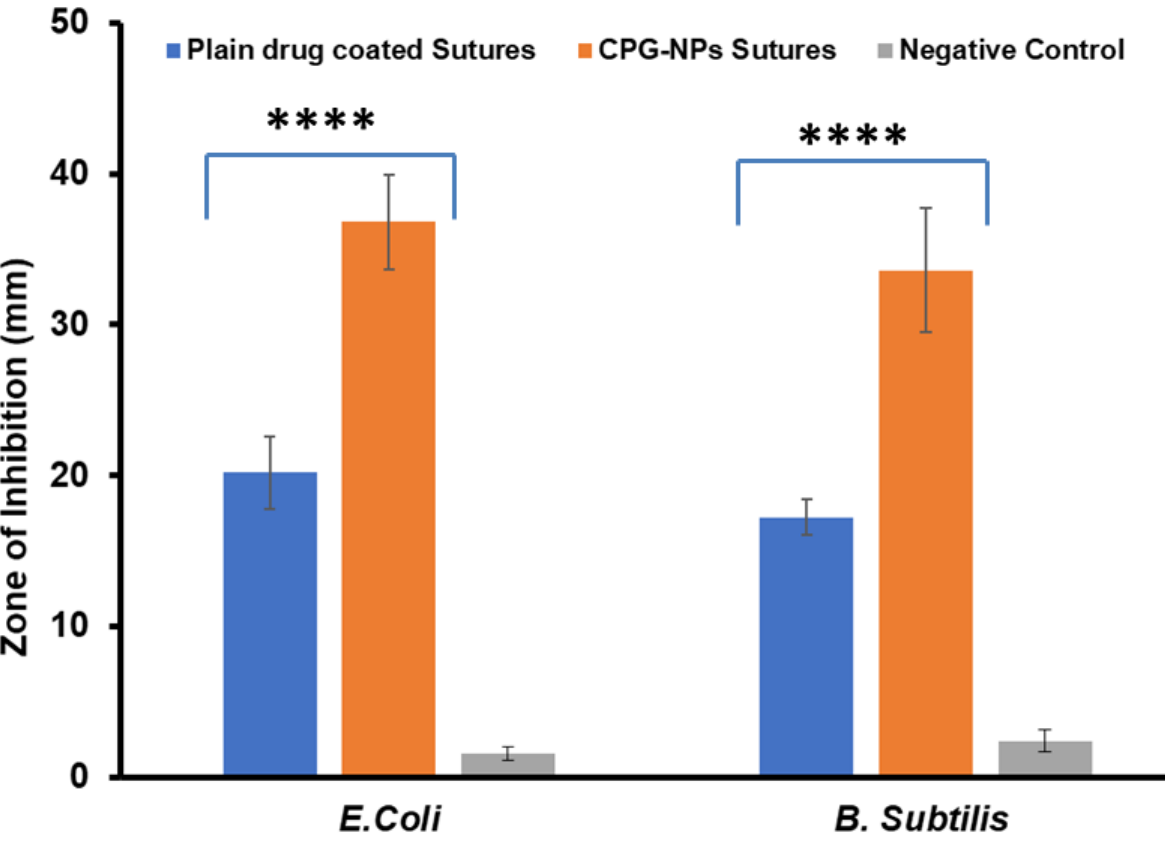
Figure 4. Comparison of antibacterial properties. Zone of inhibition (mm) of plain drug-coated (CPH) sutures and CPG-NP sutures on B. subtilis and E. coli ( n = 3). **** p < 0.0001 plain drug-coated sutures (CPH) vs. CPG-NP-coated sutures.